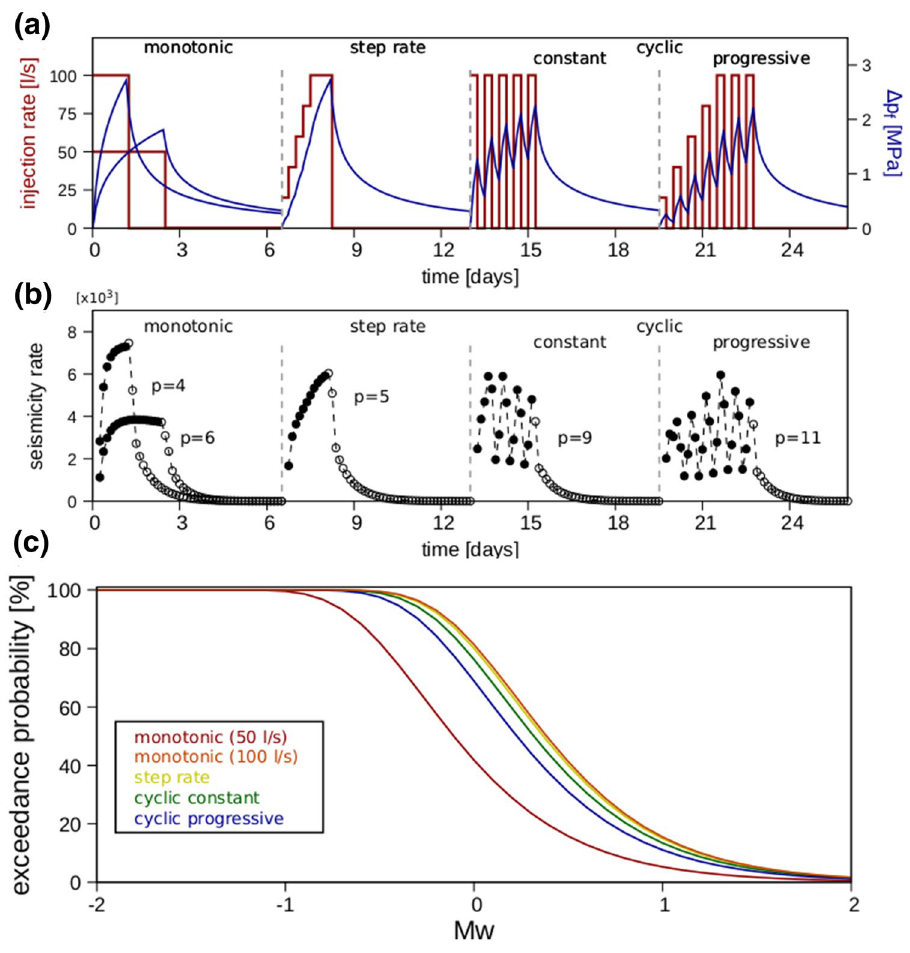
Figure 2. Effects of injection protocols on induced seismicity rates and magnitudes. ( a ) Injection rates (red curves) and computed wellhead overpressure (blue curves) for the tested injection protocols. ( b ) Resulting seismicity rates and the power-law exponents (Eq. 8) that best fit the post-injection decay curves (empty circles). ( c ) Cumulative exceedance probability of a given magnitude Mw (Eq. 9). Each scenario lasted 6.5 days and used the same amount of net injected fluid volume (10,800 m 3 ) and hydraulic energy (Figure S1). Different cases (upper and middle panels) have been shifted in time to ease visual